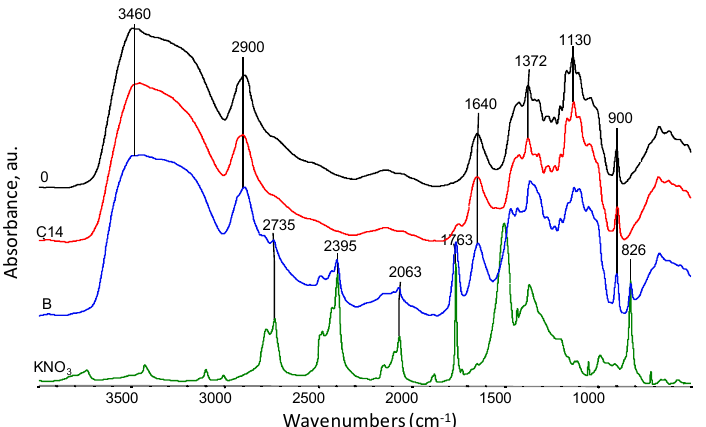
Figure 8. Summary of FTIR spectra for samples: 0—viscose nonwoven, B—KNO 3 modified nonwo- ven, C14—modified nonwoven C after 14 weeks of study, and KNO 3 salt spectrum at 4000–400 cm − 1 . On the FT-Raman spectrum (Figure 9) for a sample of nonwoven modified with KNO 3 (sample B), all characteristic absorption bands appearing in the salt spectrum were observed: 1362 cm − 1 , 1340 cm − 1 , 1051 cm − 1 and 715 cm − 1 . Moreover, a strong influence of salt on the characteristic absorption bands present in pure viscose (sample 0) is evident. The reduction of sharp bands at the maximum of wavenumbers 1370 cm − 1 and 1093 cm − 1 [36,37], which are characteristic for the C-O-C groups in oxygen bridges, proves that the cellulose structure is the loosened and swollen as a result of salt